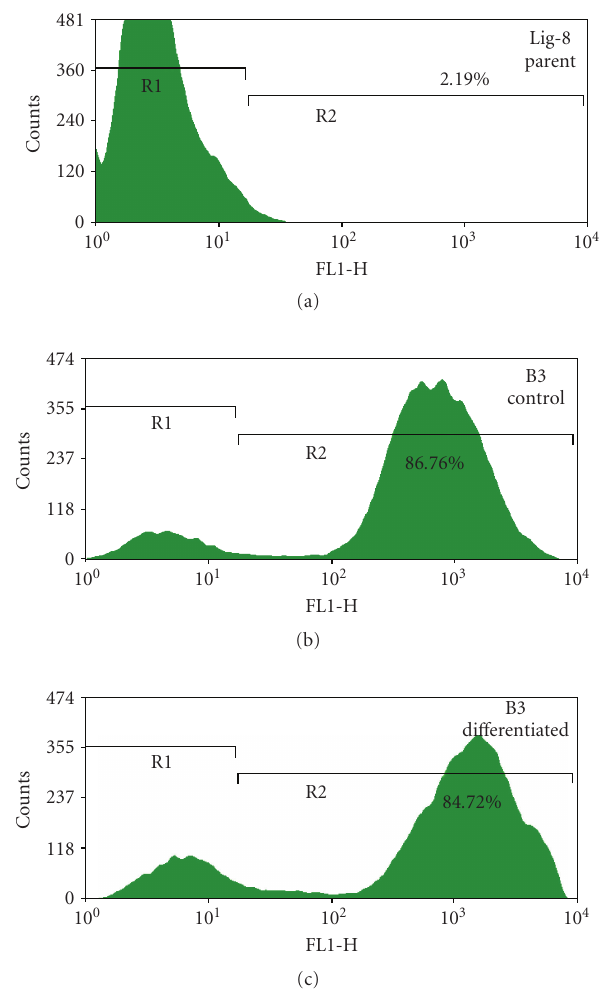
Figure 5: CFP-fluorescence expression of the rat hepatic ASC clone B3 is stable after induction of di ff erentiation . Flow cytometry analy- sis was performed with cultures of the nontransfected parental rat hepatic ASC strain, Lig-8 (a), and CFP-fluorescent clone B3 hepatic ASC cultures. The B3 cells were evaluated under routine (b) and di ff erentiating (c) culture conditions. Histograms plot the relative numbers of cells as a function of the log-relative CFP fluorescence per cell. The background fluorescence, as defined by nontransfected Lig-8 cells is depicted as the R1 region, and positive fluorescence is denoted by the R2 region. Numbers indicate the percent of cells positive for CFP fluorescence